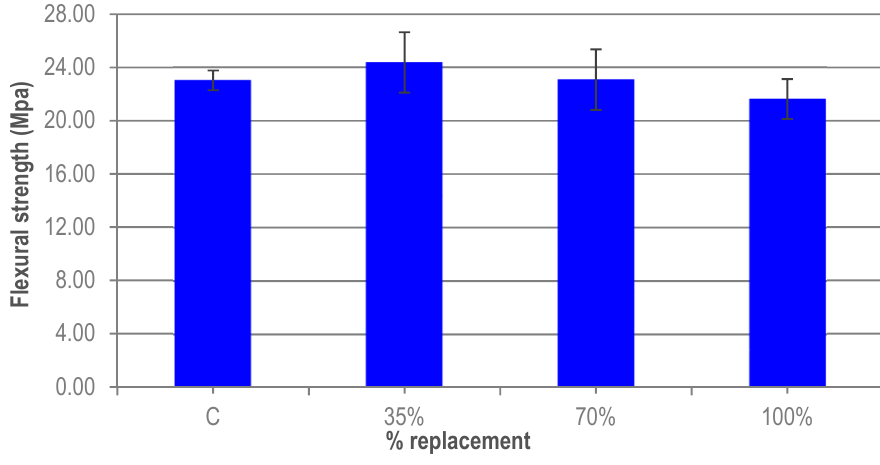
Figure 7. Flexural strength of UHPC.